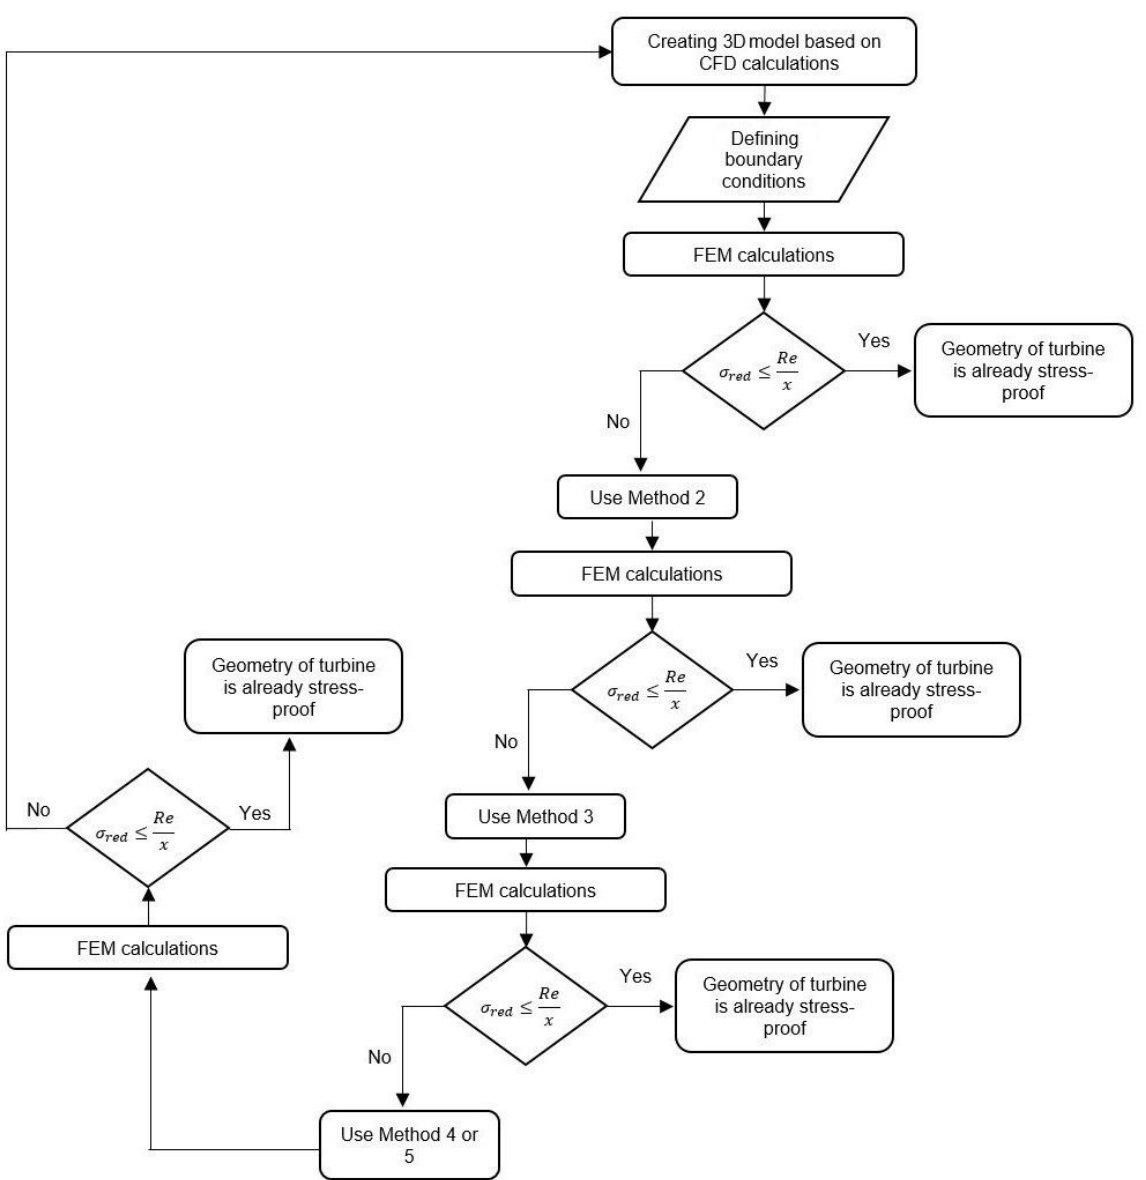
Figure 25: Stress reduction optimisation algorithm for radial-axial gas microturbine